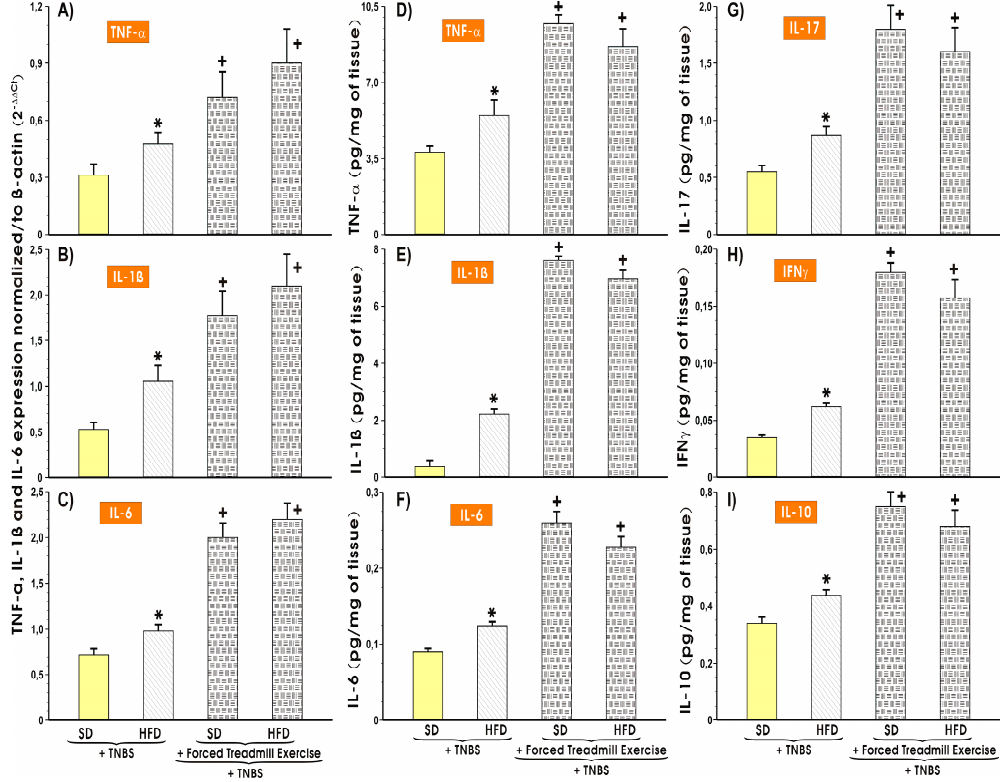
Figure 5. The effect of forced treadmill exercise on the mRNA expression of TNF- α ( A ), IL-1 β ( B ), and IL-6 ( C ) and the colonic mucosal tissue levels of IL-1 β ( D ), IL-17 ( E ), IL-6 ( F ), TNF- α ( G ), IFN γ ( H ), and IL-10 ( I ) in mice with TNBS-induced colitis fed SD or HFD with or without forced treadmill exercise. Results are Mean ± S.E.M. of 6 animals per each experimental group. Asterisk indicates a significant change ( p < 0.05) as compared with respective values in sedentary mice fed SD with colitis. Cross indicates a significant change ( p < 0.05) as compared with respective values in animals fed SD or HFD but not subjected to forced exercise sessions.